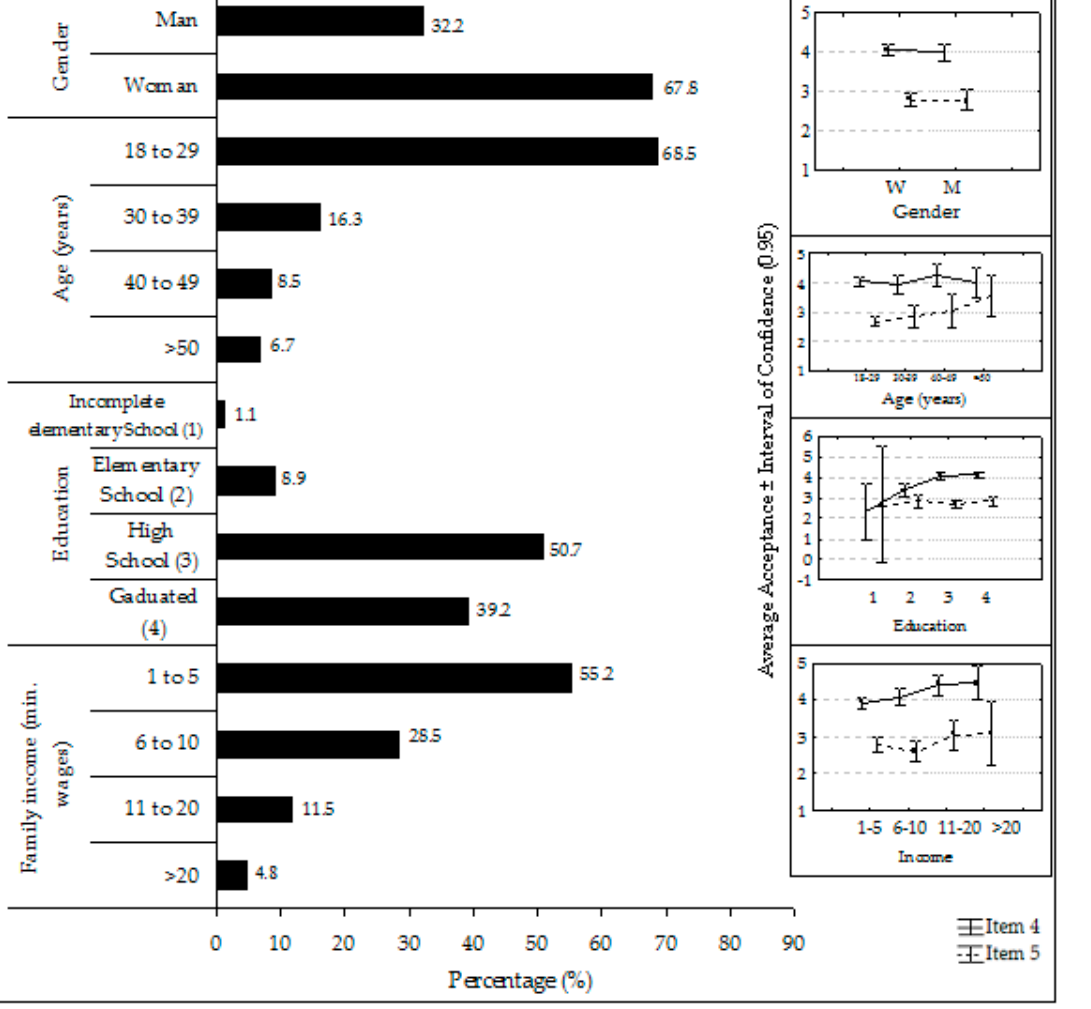
Figure 2. Socio-demographic characteristics of the participants ( n = 270) and their influence on the acceptance of functional foods on a Likert scale. Item 4: “if they taste good”; Item 5: “if they taste worse than their conventional counterpart foods”.